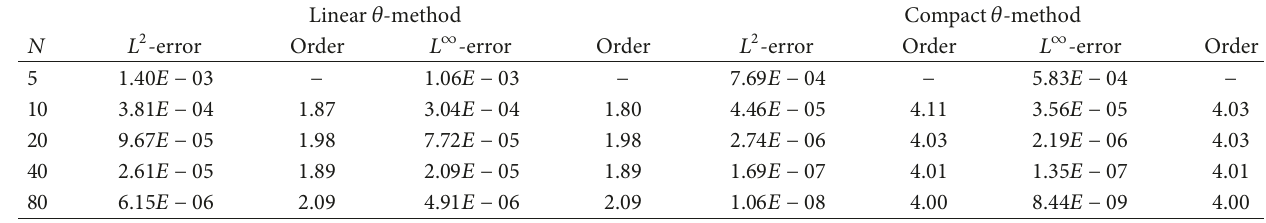
Table 3: Errors and convergence orders when 𝜃 = 0.5 , 𝑇 = 2 , and 𝜏 = 0.5.